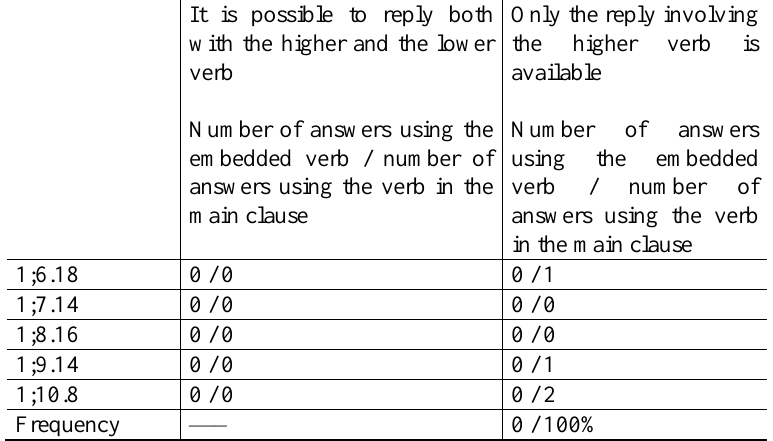
Table VIII. Verbal answers / confirmations of questions / declarative sen- tences presenting embedding in Tomás’ data. It is possible to reply both with the higher and the lower verb Number of answers using the embedded verb / number of answers using the verb in the main clause